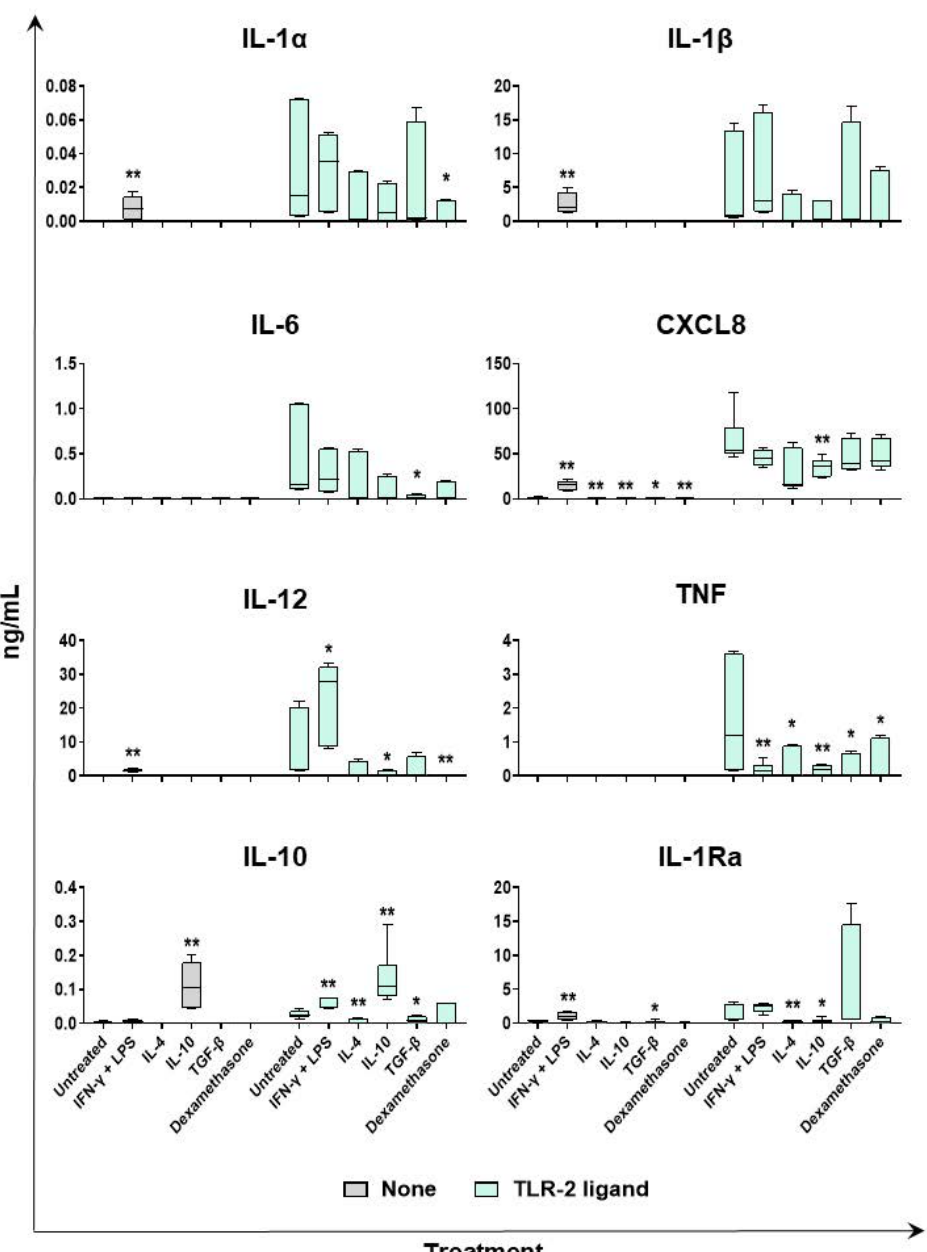
Figure 7. Ability of diverse macrophage subsets to release proinflammatory and anti-inflammatory cytokines in response to TLR2 agonist stimulation. The moM Φ were left untreated, or they were stimulated with diverse polarizing factors: IFN- γ + LPS (both at 100 ng/mL), IL-4 (20 ng/mL), IL-10 (20 ng/mL), TGF- β (20 ng/mL), or dexamethasone (20 ng/mL). Then 24 h later, culture supernatants were replaced with fresh media and cells were left untreated or activated using a TLR-2 ligand (Mag-Pam2Cys_P80, 100 ng/mL); 24 h later, the amounts of IL-1 α , IL-1 β , IL-6, CXCL8, IL-12, TNF, IL-1Ra, ad IL-10 in culture supernatants were determined using a multiplex ELISA. Data from three independent experiments utilizing different blood donors are presented. Data are displayed as box- and-whisker plots, showing the median and interquartile range (boxes) and minimum and maximum values (whiskers). For each cytokine (IL- α , IL- β , IL-6, CXCL8, IL-12, TNF, IL-10, and IL-1Ra), values of treated macrophages were compared to the untreated control (moM Φ ) using a Mann–Whitney test. ** p < 0.01, and * p <